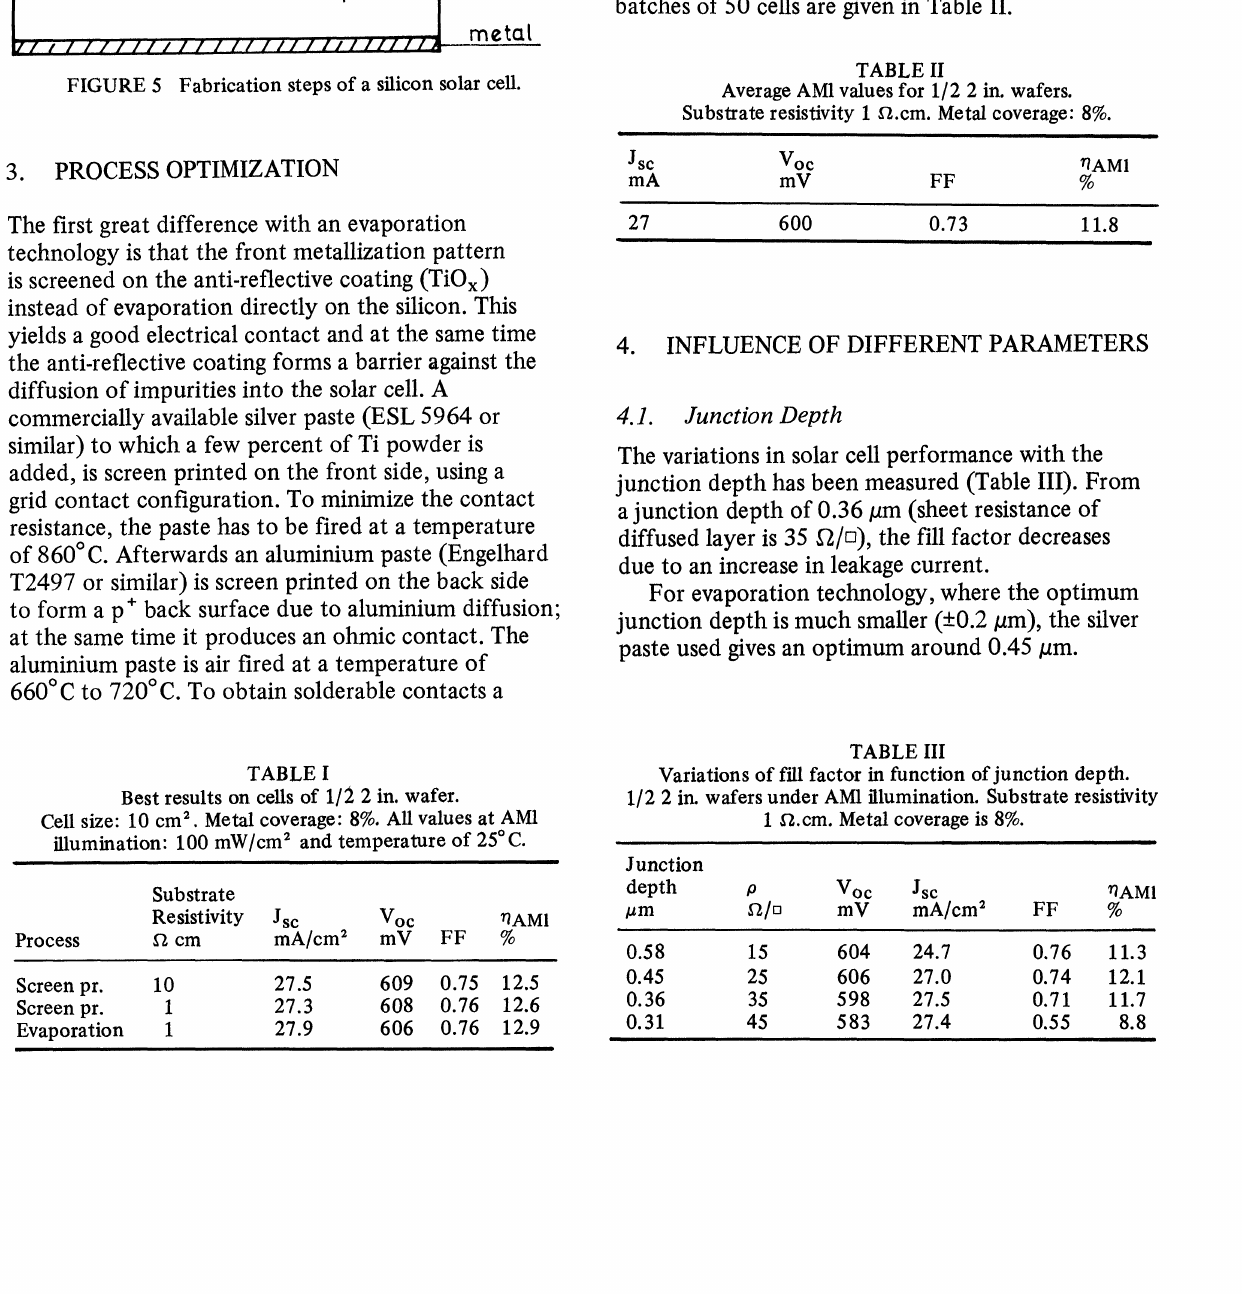
TABLE II Average AM1 values for 1/2 2 in. wafers.